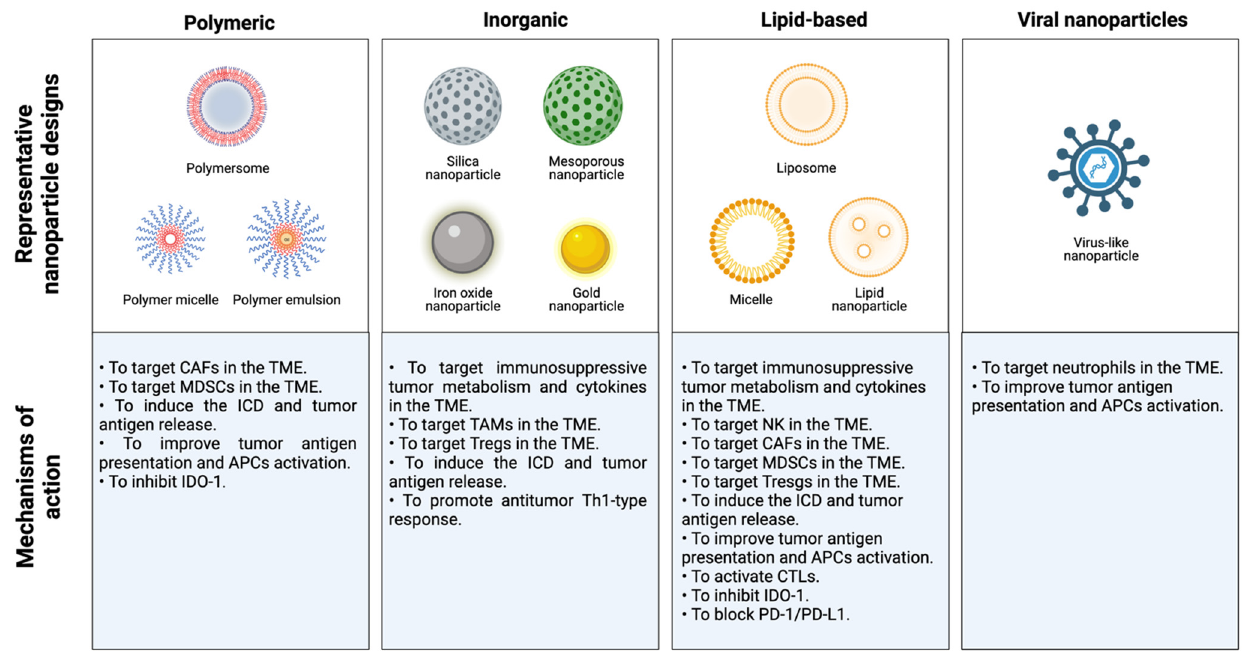
Figure 3. Representative classes of nanoparticle designs and mechanisms of action to overcome mechanisms of cancer immune escape. CAFs: carcinoma-associated fibroblasts; TME: tumor microen- vironment; MDSCS: myeloid-derived suppressor cells; ICD: immunogenic cell death; APCs: antigen- presenting cells; IDO-1: indoleamine 2,3-dioxygenase 1; TAMs: tumor-associated macrophages; Tregs: regulatory T cells; NK: natural killer; CTLs: cytotoxic T lymphocytes; PD-1: programmed cell death protein 1; PD-L1: programmed cell death ligand 1.